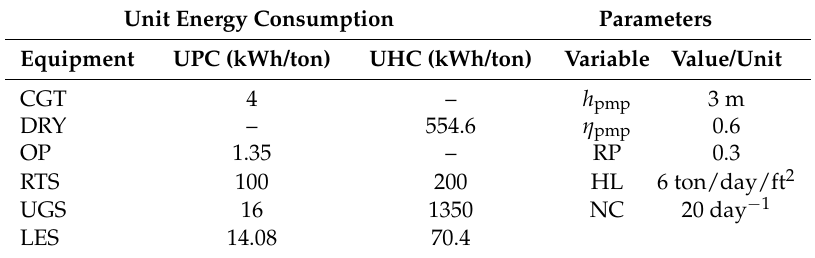
Table 3. Parameters used to estimate the power and heat consumption of all the equipment in the superstructure shown in Figure 1.